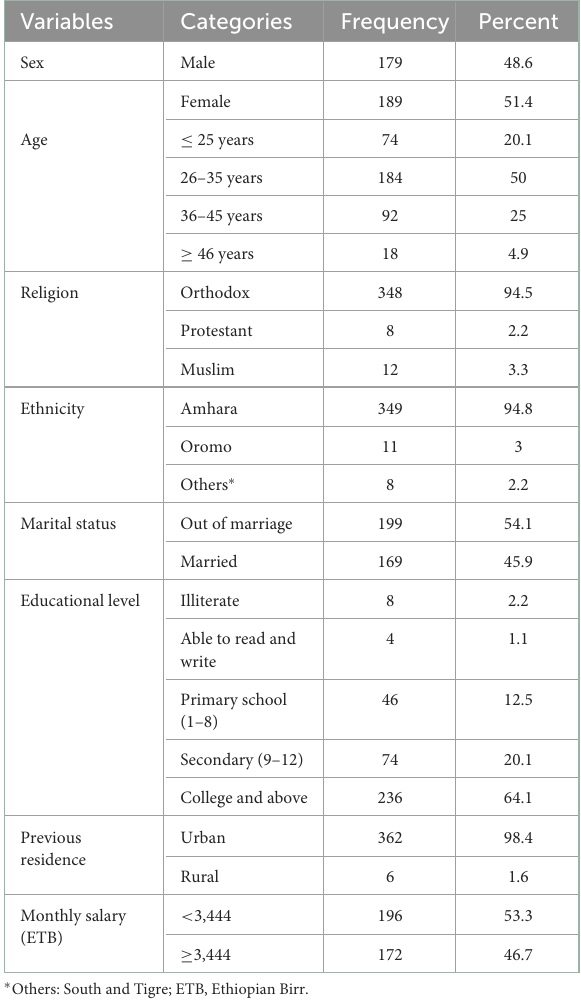
TABLE 1 Socio-demographic characteristics of the Bure industry park construction workersin Northwest Ethiopia.